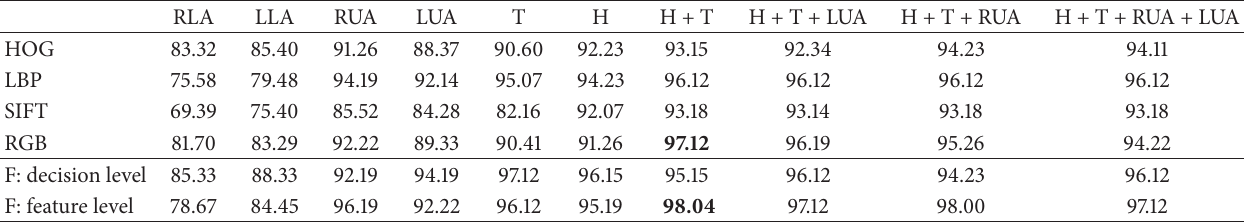
Table 1: Gender recognition accuracies (%) with annotated body parts on Buffy. T: torso, H: head, LUA: left upper arm, RUA: right upper arm, LLA: left lower arm, and RLA: right lower arm. They are also used in other tables and figures.